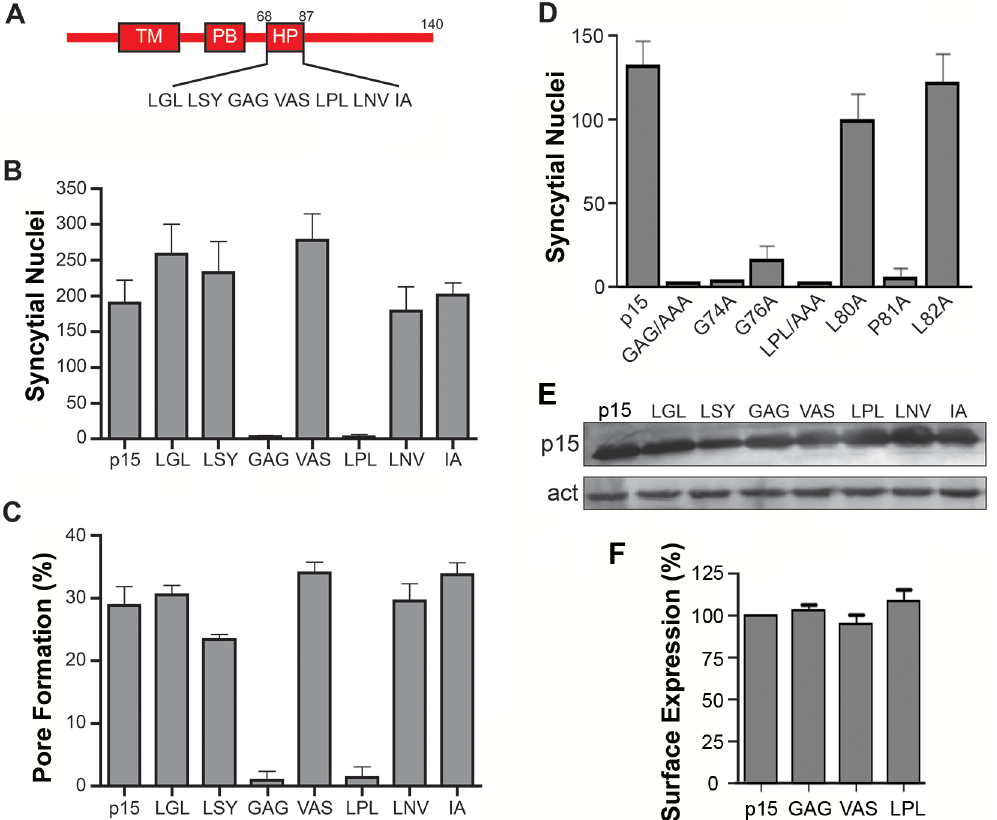
Fig 1. Centrally-located glycine and proline residues in the p15 HP are essential for cell-cell fusion. (A) Schematic of the p15 protein indicating locations of the transmembrane domain (TM), polybasic cluster (PB) and hydrophobic patch (HP). Numbers indicate residue positions in p15. Sequence of the HP is depicted below. (B) Transfected QM5 cells expressing wt p15 or p15 mutant proteins containing triple Ala substitutions of the indicated three consecutive HP residues were Giemsa-stained at 9 h post-transfection and the mean ± SEM of syncytial nuclei per microscopic field were quantified by bright